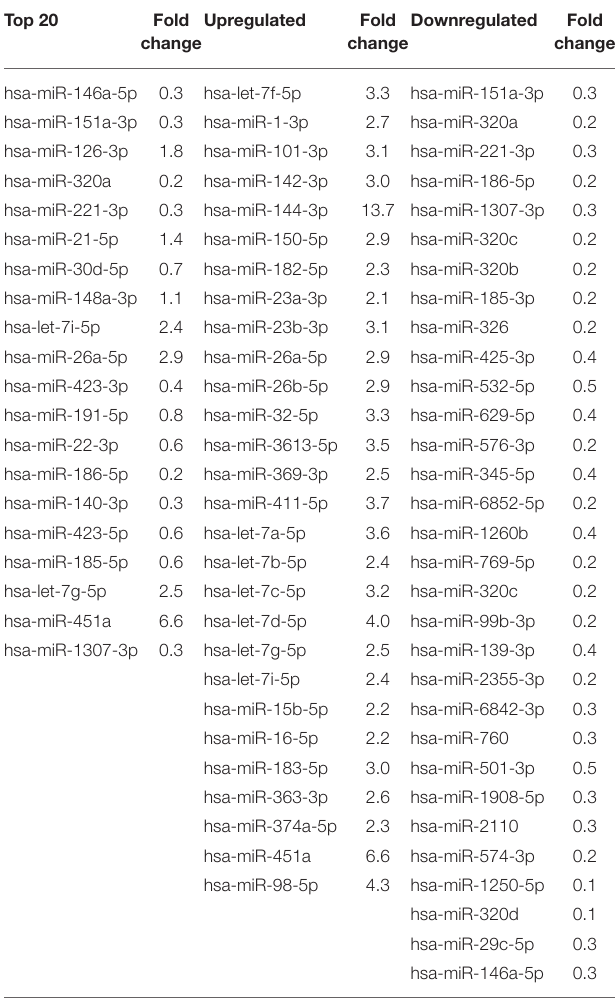
TABLE 3 | Impact of Intercept treatment on the microRNA profile of platelet-derived MPs. Top 20 Fold changeUpregulated Fold changeDownregulated Fold